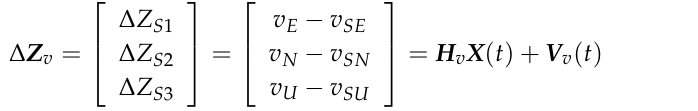
Figure 2. The integrated principle of SINS/SRS integrated subsystem. The measurement of SINS/SRS integrated subsystem can be chosen as the difference between the velocities of SINS and SRS as well as the difference of altitude between the radar altimeter and SINS. Suppose the spacecraft velocities obtained by SRS and SINS